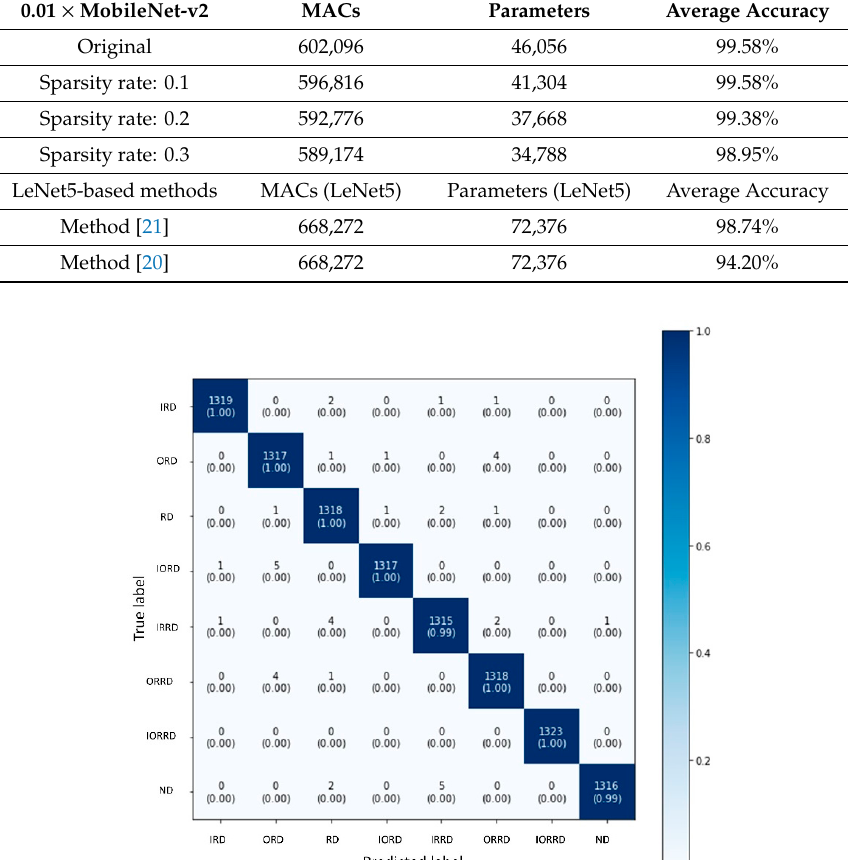
Figure 7. Confusion matrices for testing results of the proposed method at a scaling rate of 0.01.